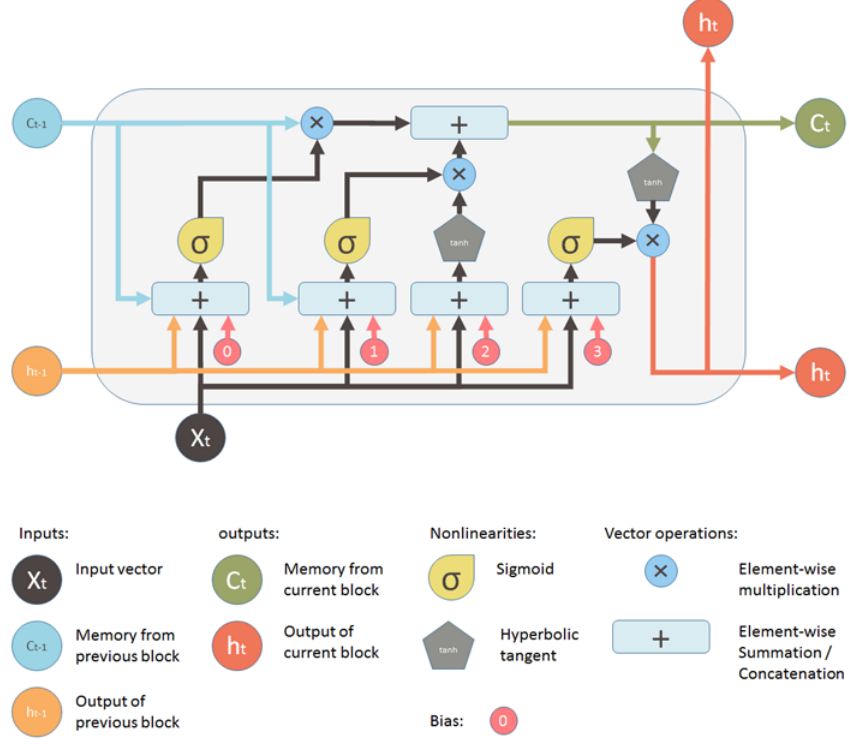
Figure 3. LSTM building block units redrawn from Yan. S. Medium Review article [42].